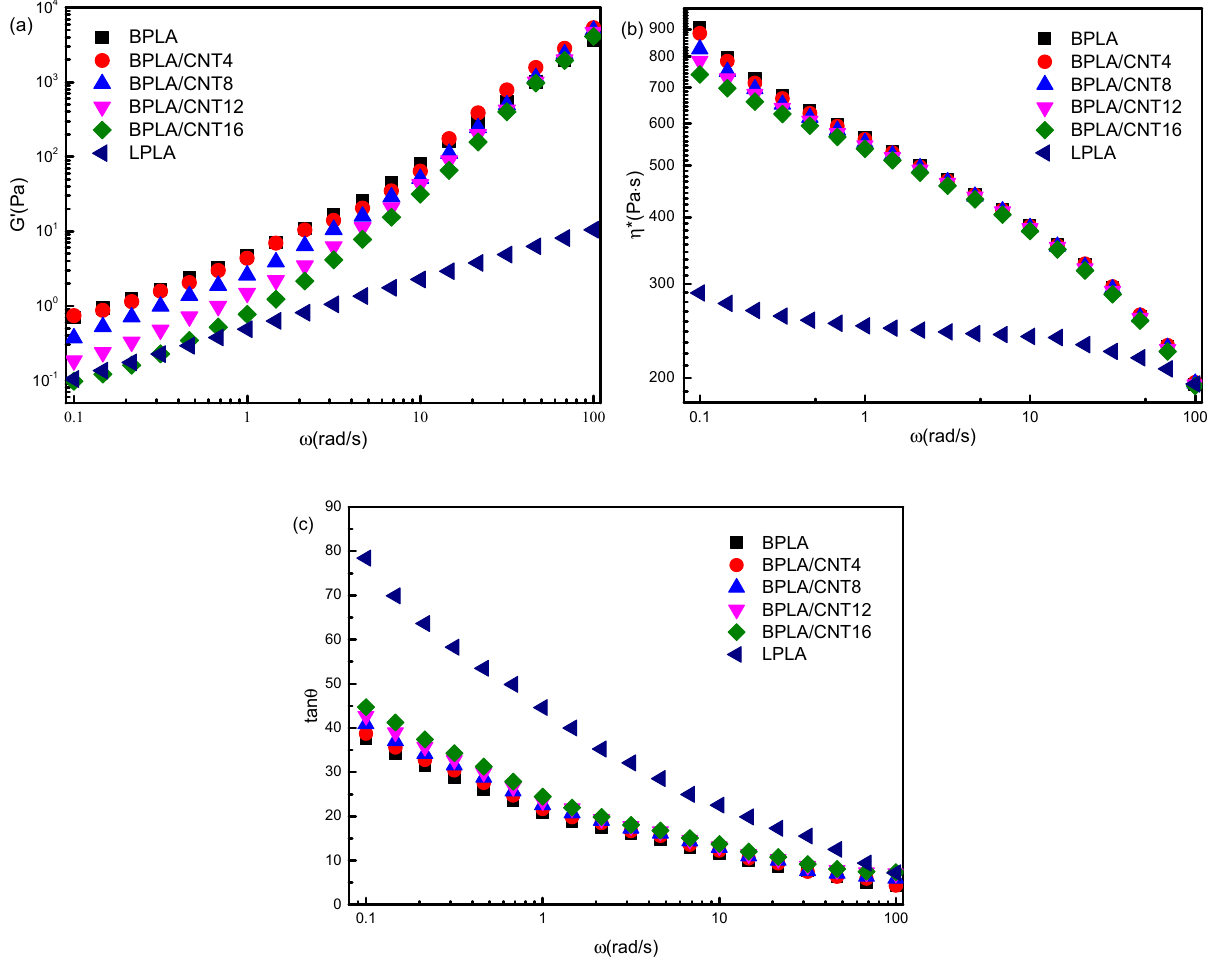
Figure 5: Rheological curves of BPLA/CNT: ( a ) storage module curves, ( b ) complex viscosity curves, and ( c ) loss factor